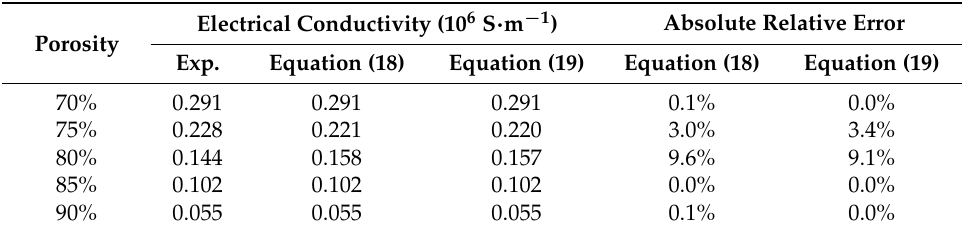
Table 3. Experimental data from Zhou et al. [40] and calculated values of electrical conductivity of sintered copper fibres using the newly proposed models.